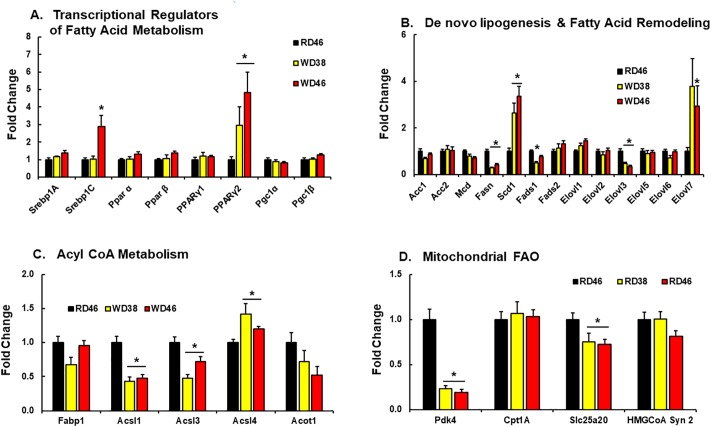
Western diet effects on hepatic gene expression linked to transcriptional regulators of fatty acid metabolism (A), de novo lipogenesis & fatty acid remodeling (B), acyl CoA metabolism (C) and mitochondrial fatty acid oxidation (FAO) (D). Hepatic transcripts were quantified by qRTPCR using cyclophilin as the reference gene. Transcript (mRNA) abundance is expressed as fold change (mean ± SEM, N = 7–8/group), *, FDR ≤ 0.05 versus the RD46 group. [A: SREBP, sterol regulatory element binding protein; PPAR, peroxisome proliferator activated receptor; PGC, PPARγ co-activator]; [B: Acc, acetyl CoA carboxylase; Mcd, malonyl CoA decarboxylase; Fasn, fatty acid synthase; Scd1, stearoyl CoA desaturase; Fads, fatty acid desaturase; Elovl, fatty acid elongase]; [C: Fabp, fatty acid binding protein; Acsl, acyl CoA synthetase-long chain; Acot, acyl CoA thioesterase]; [D: Pdk4, pyruvate dehydrogenase kinase-4, Cpt1a, liver carnitine palmitoyl transferase 1a; Slc25a20, carnitine acyl-carnitine translocase; Hmg CoA syn 2, HMG CoA synthase 2].